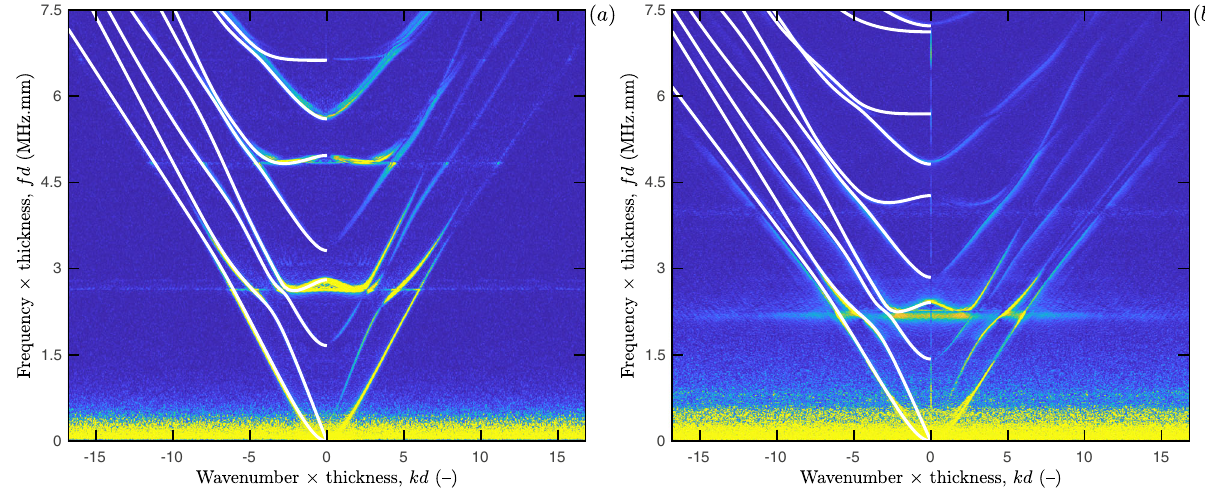
Fig. 5 Inverse problem solutions. Optimal matching between the measured and modelled guided modes for ( a ) dry and ( b ) liquid-infused nanoporous